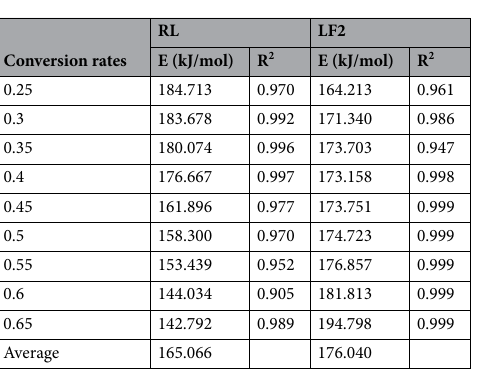
Conversion rates